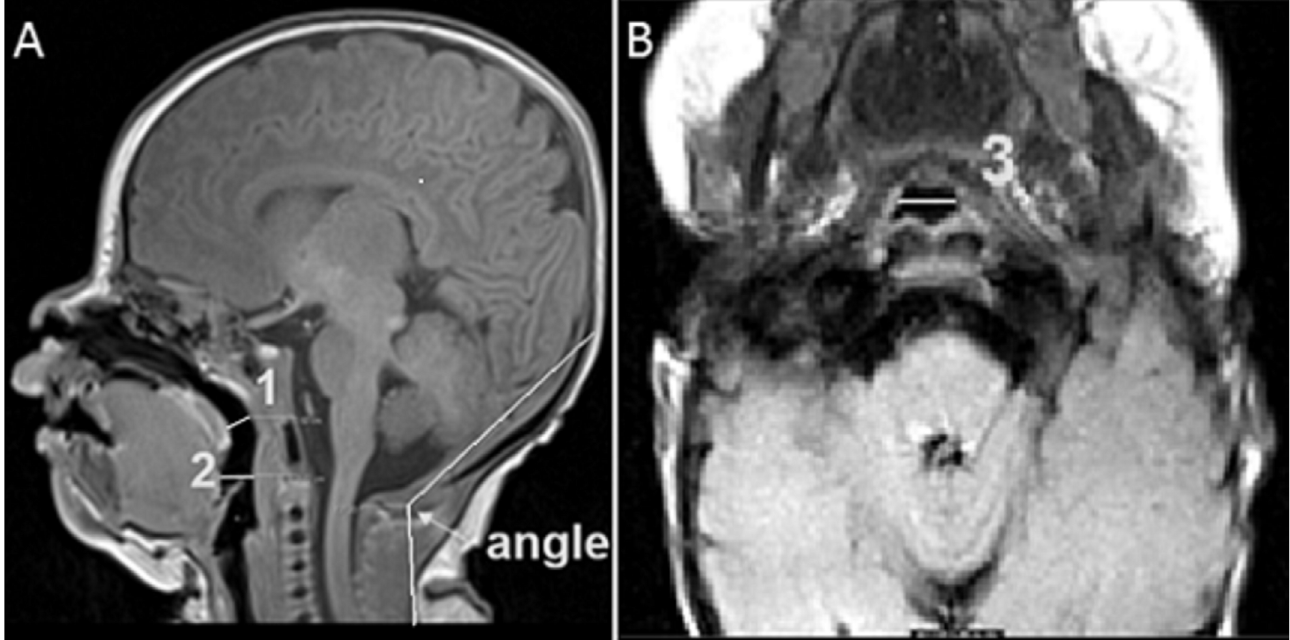
Fig 1. A — T1-weighted MR image of head-neck region of a newborn infant showing head-tilt angle between the occipito-ophisthion-C7 spinous process, AP diameters of airway at the level of palate (1) and tongue (2) in mid-sagittal plane. B — Axial T1-weighted MR image of head-neck region of a newborn infant showing lateral diameter of airway at the tongue level